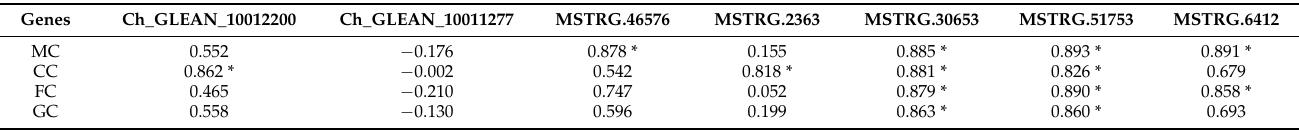
Table 3. Correlations between expression of carotenogenic and fatty acid biosynthesis genes (cofactors, Pearson Correlation in SPSS